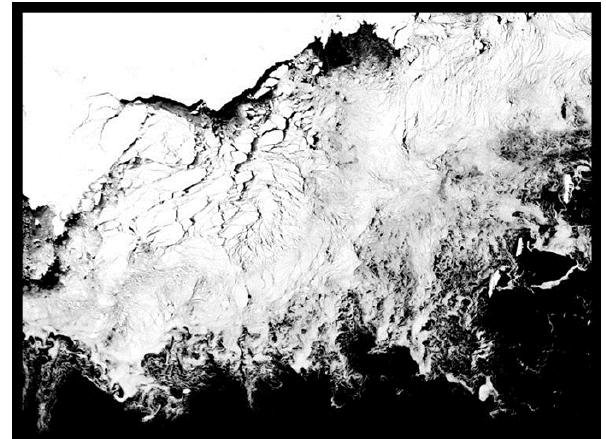
Figure 1. The 1km cloud-free MODIS image 3000km × 2200km. The scene is situated north of McMurdo Station and east of the Ross Sea, Antarctica. Ice concentrations between 0% (black) and 100% (white). The scene is recorded at 03:30UTC 24 February 2008 by the Aqua satellite. The scene centre is at 69.5 ◦ S, 165 ◦ W.